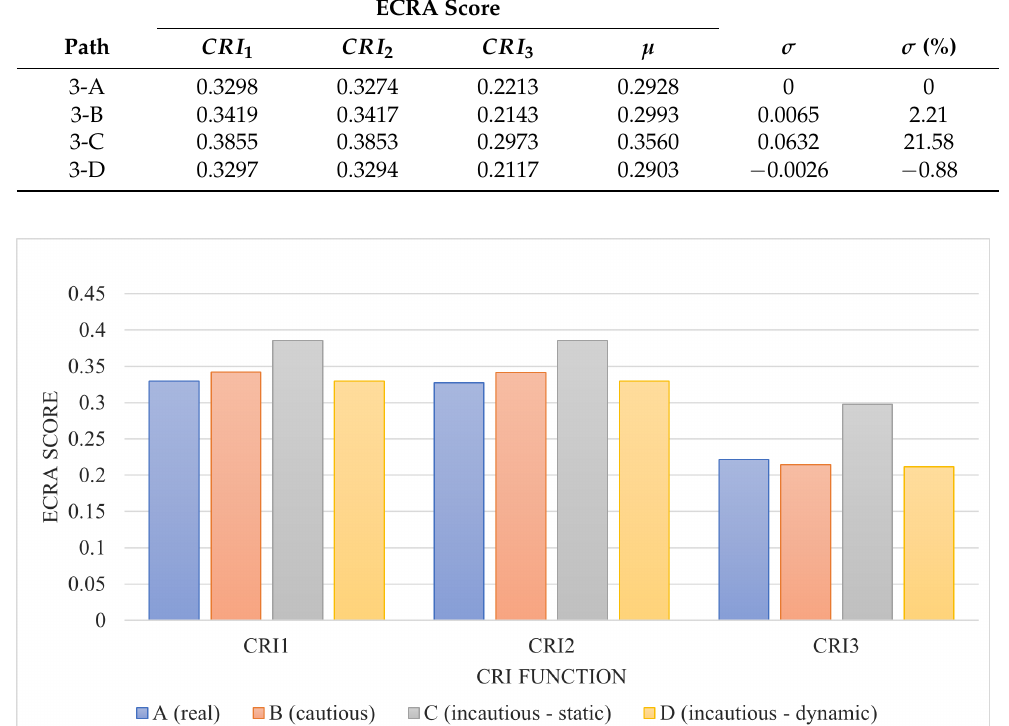
Table 5. ECRA scores in test case 3 for four proposed scenarios using three different CRI methods. ECRA Score